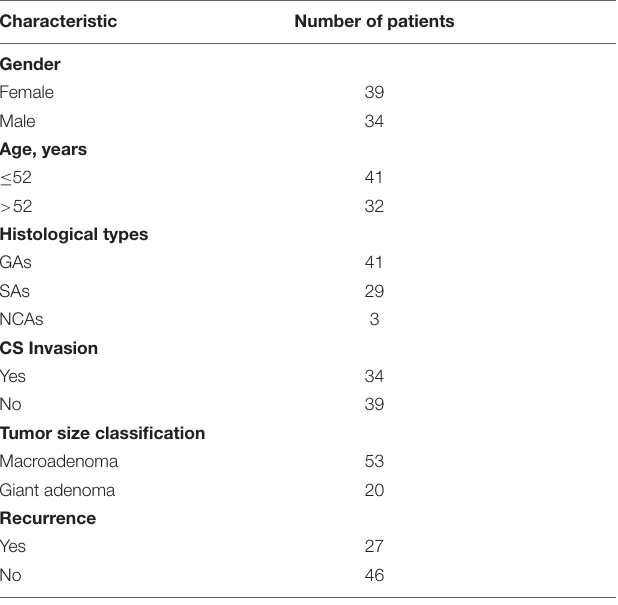
TABLE 1 | Summary of patient demographics and clinical characteristics.